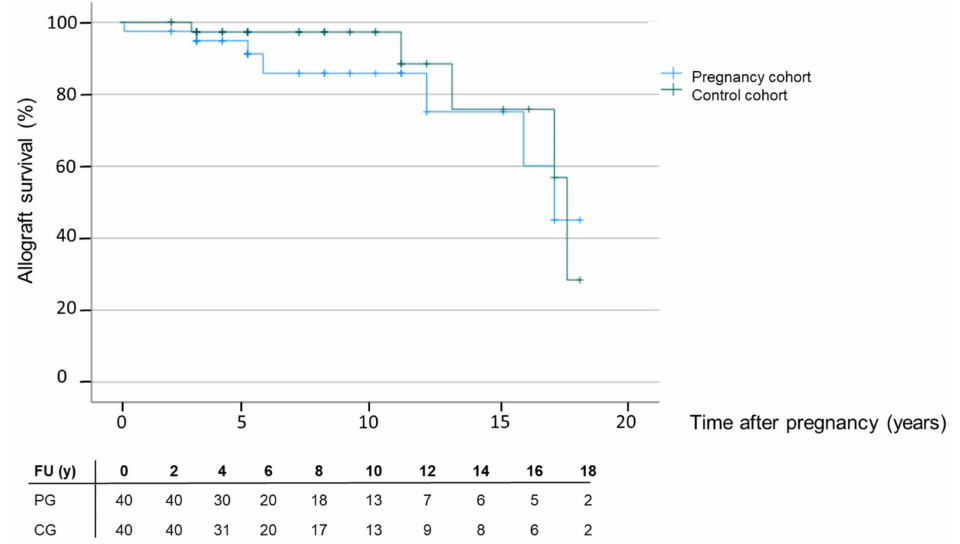
Figure 3. Kaplan–Meier estimates of allograft survival in women with post-transplant pregnan- cies (blue line) versus women without post-transplant pregnancies (green line) during the same observation